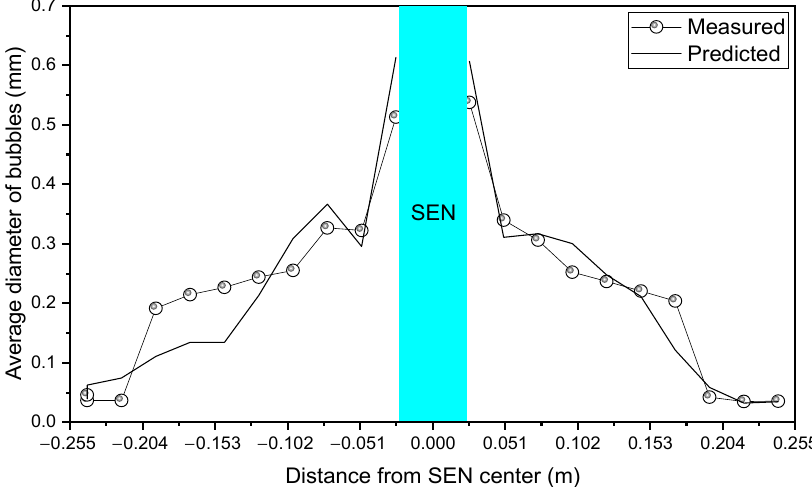
Figure 3. Comparison between the measured and the predicted result of the average bubble diameter along the width of the mold.